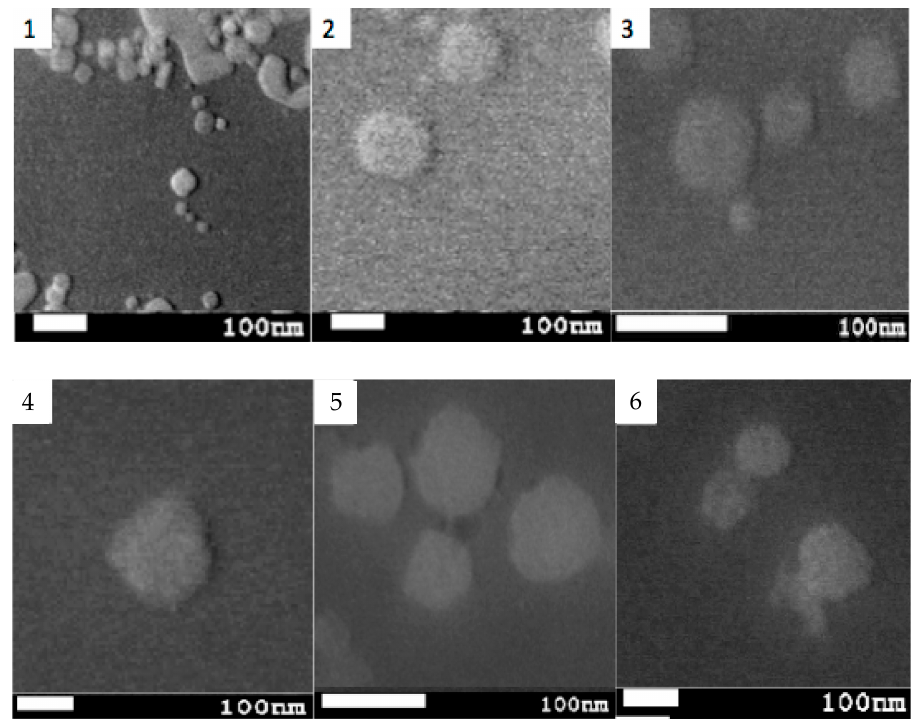
Figure 4. SEM images illustrating the lipomics’ size and morphology from ( top ) formulations 4.2 and ( bottom ) 8.2. Scale-bar is equivalent to 100 nm.